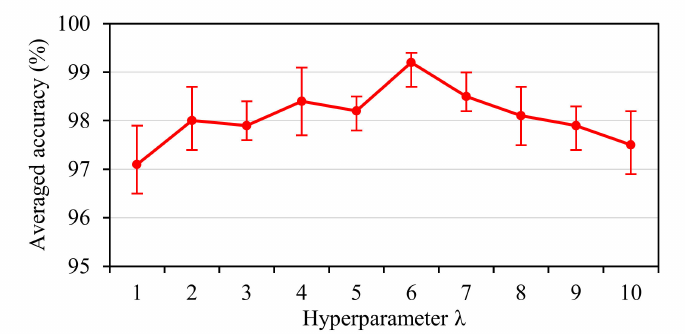
Figure 4. Diagnosis accuracy of the proposed method according to different values of the hyperpa- rameter λ